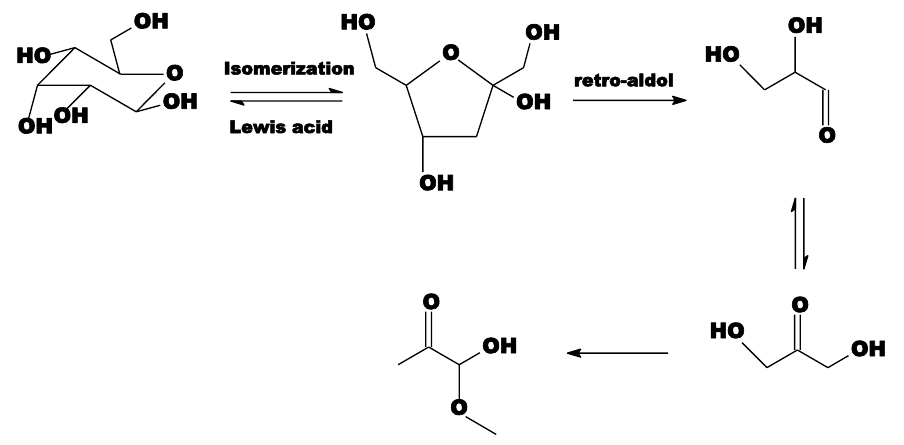
Figure 5. The conversion of glucose into methyl lactate in near-critical methanol solution over MOF-74 catalytic materials.